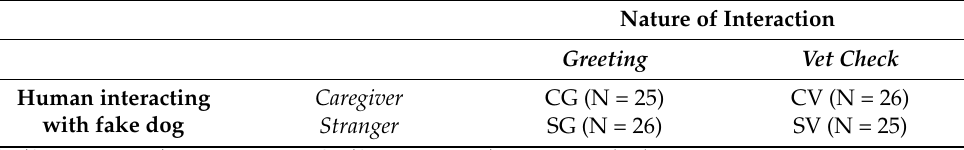
Table 1. Between-subject design of the experiment and number of dogs tested in the four test groups/conditions. Nature of Interaction Greeting Vet Check Human interacting Caregiver CG (N = 25) CV (N = 26) with fake dog